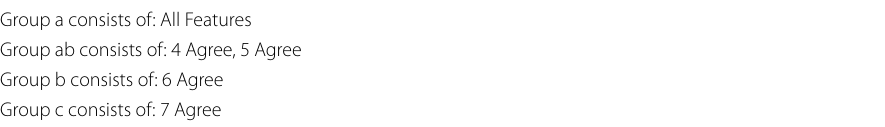
Table 42 HSD test groupings after ANOVA of AUC for the FST factor